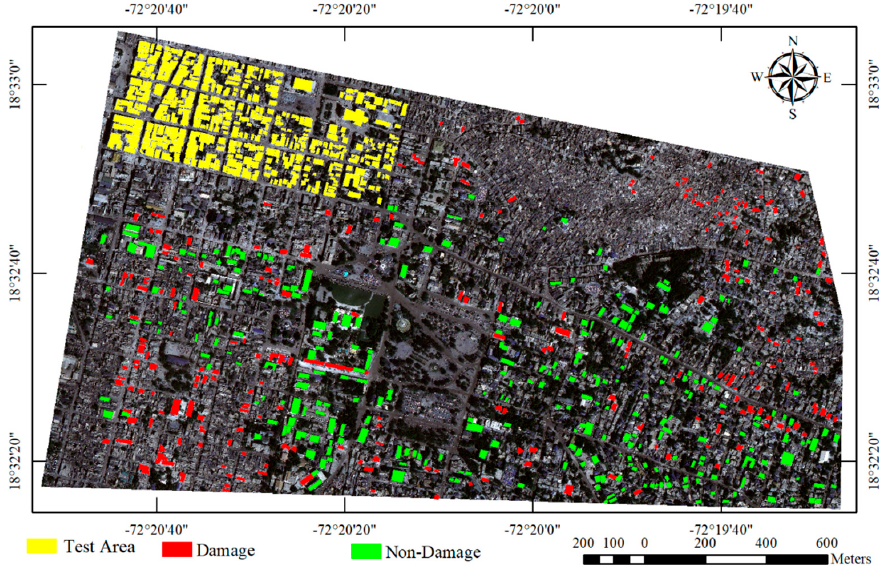
Figure 3. The case study area and spatial distribution of sample data.